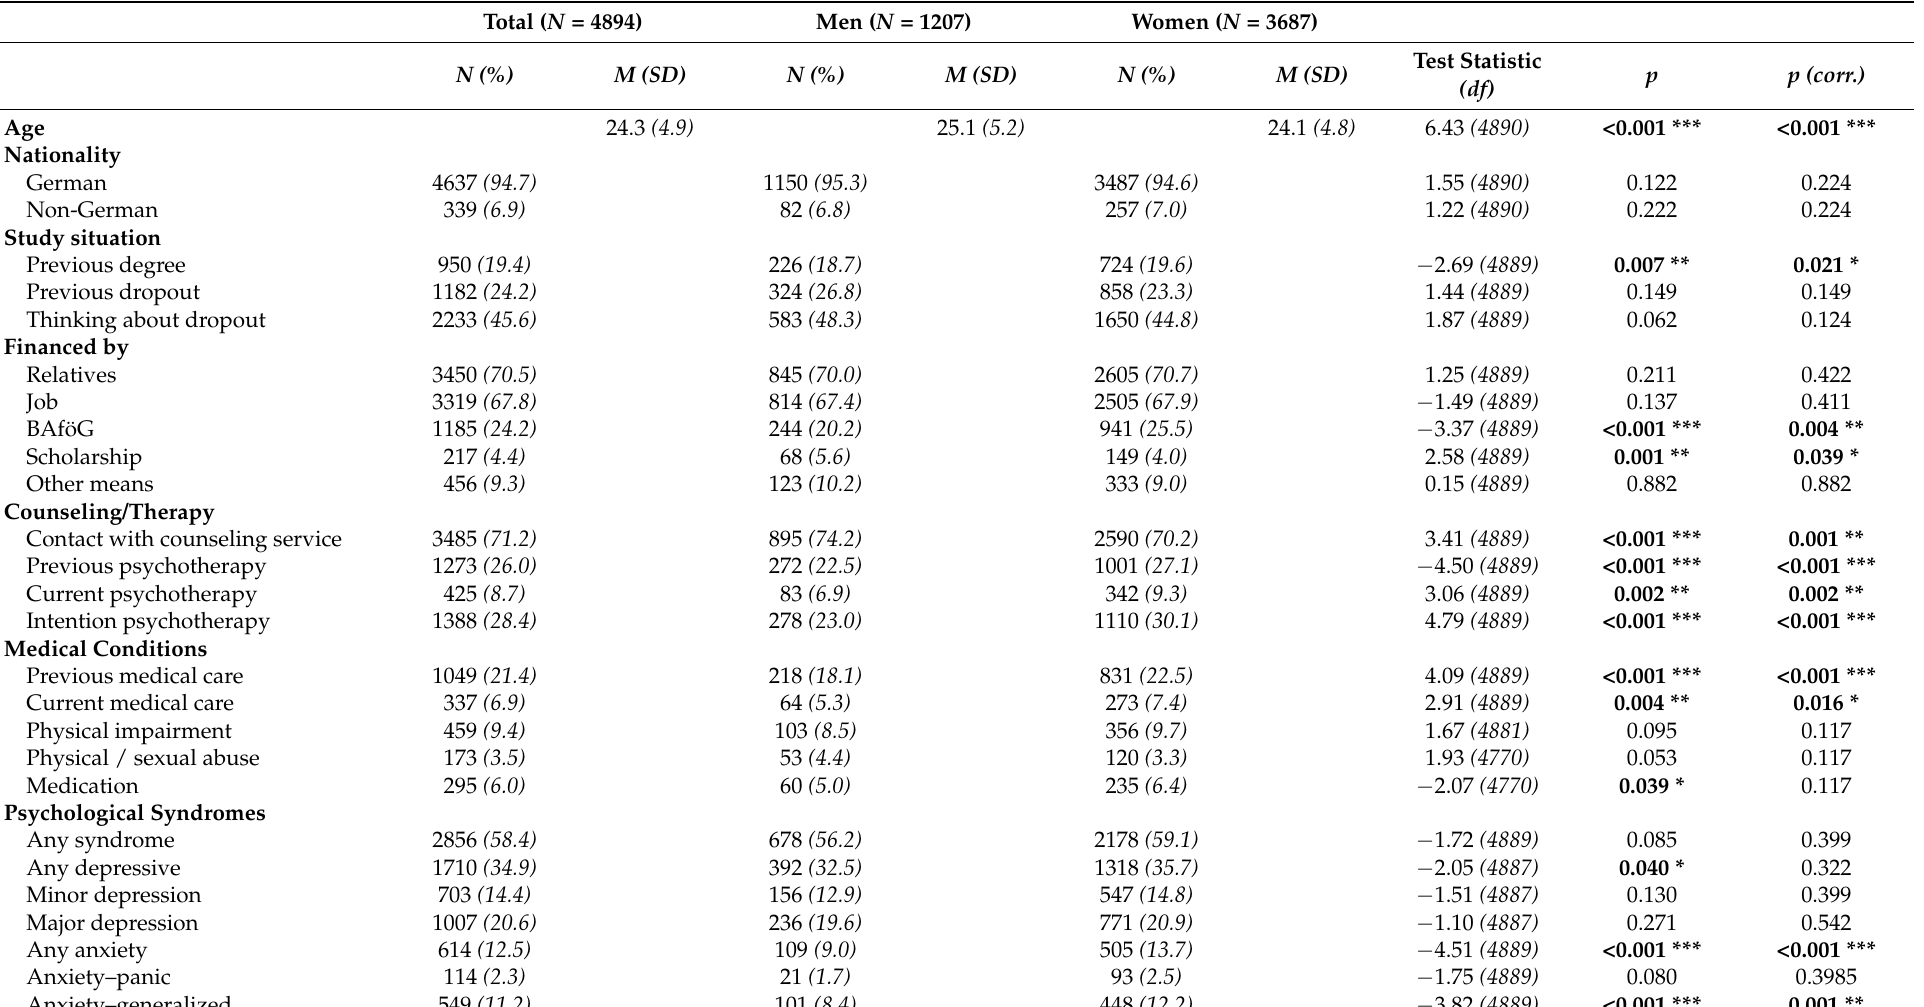
Table 1. Descriptive Statistics for the